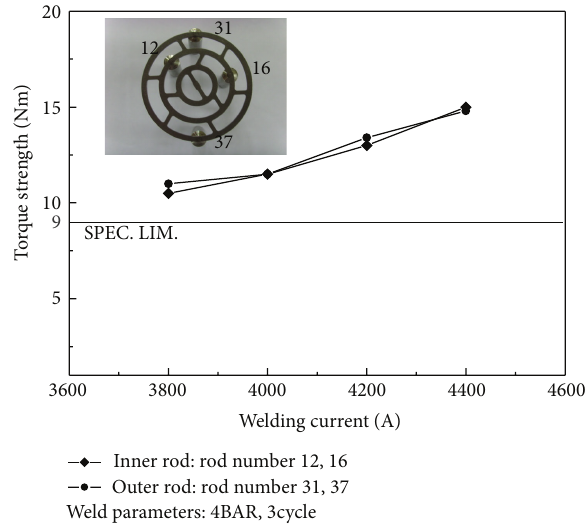
Figure 9: Torque strength of the welded specimens as a function of the weld current.